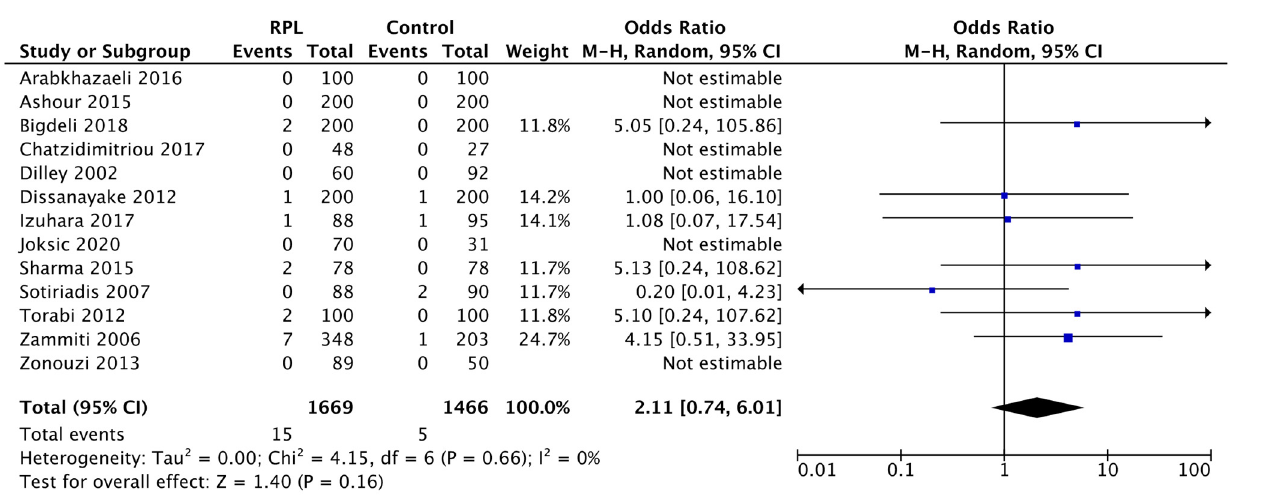
Figure 5. Forest plot of the association between H1299R homozygous and RPL. The forest plot illus ‐ trates the 95% CI for each study (black lines); the weight of each study (blue square) and the overall result (black diamond). Heterogeneity is expressed as I 2 measure. Overall effect OR: 2.11 [0.74, 6.01]; p = 0.16.